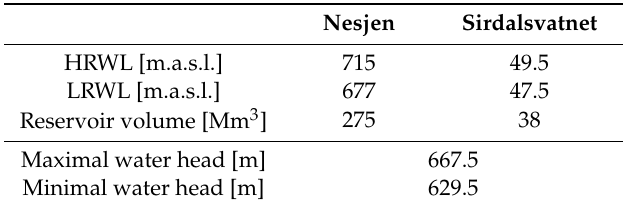
Table 2. Reservoir data.